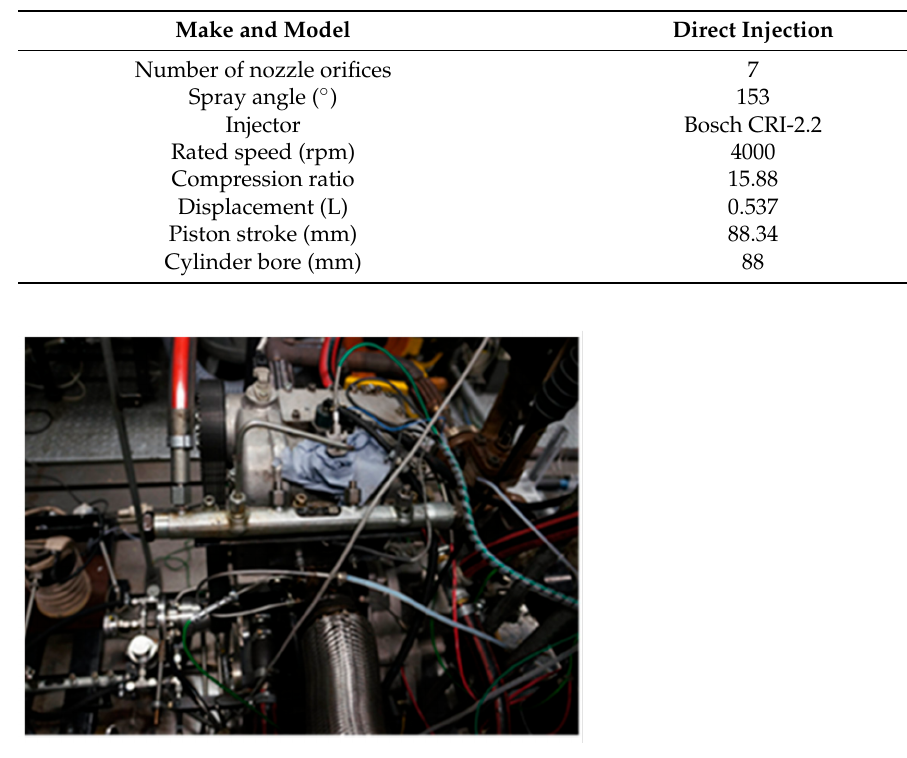
Figure 1. Test bench.